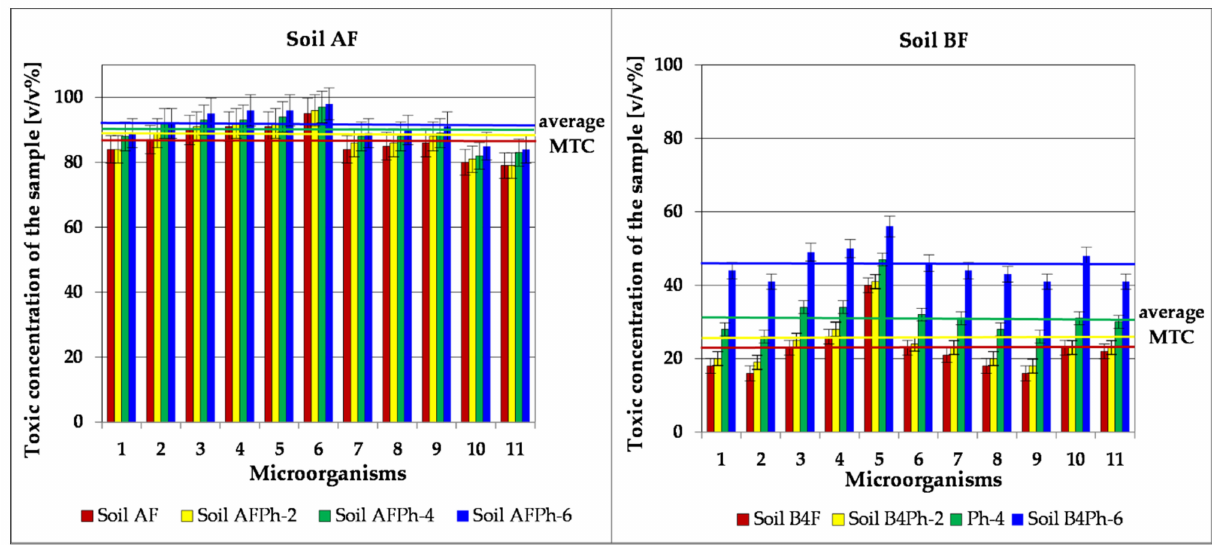
Figure 10. Environmental risk assessment test MARA for soils A and B4 during 6 months of phytoremediation augmented by soils fertilisation AF and B4F with microorganisms (1. Microbacterium spaciec , 2. Brevundimonas diminuta , 3. Citrobacter freudii , 4. Comamonas testosteroni , 5. Entrococcus casseliflavus , 6. Delftia acidovorans , 7. Kurthia gibsoni , 8. Staphylococcus warneri , 9. Pseudomonas aurantiaca , 10. Serriatia rudidaea , 11. Pichia anomala ), (MTC) Microbial Toxic Concentration (repetitions number n = 3, p <